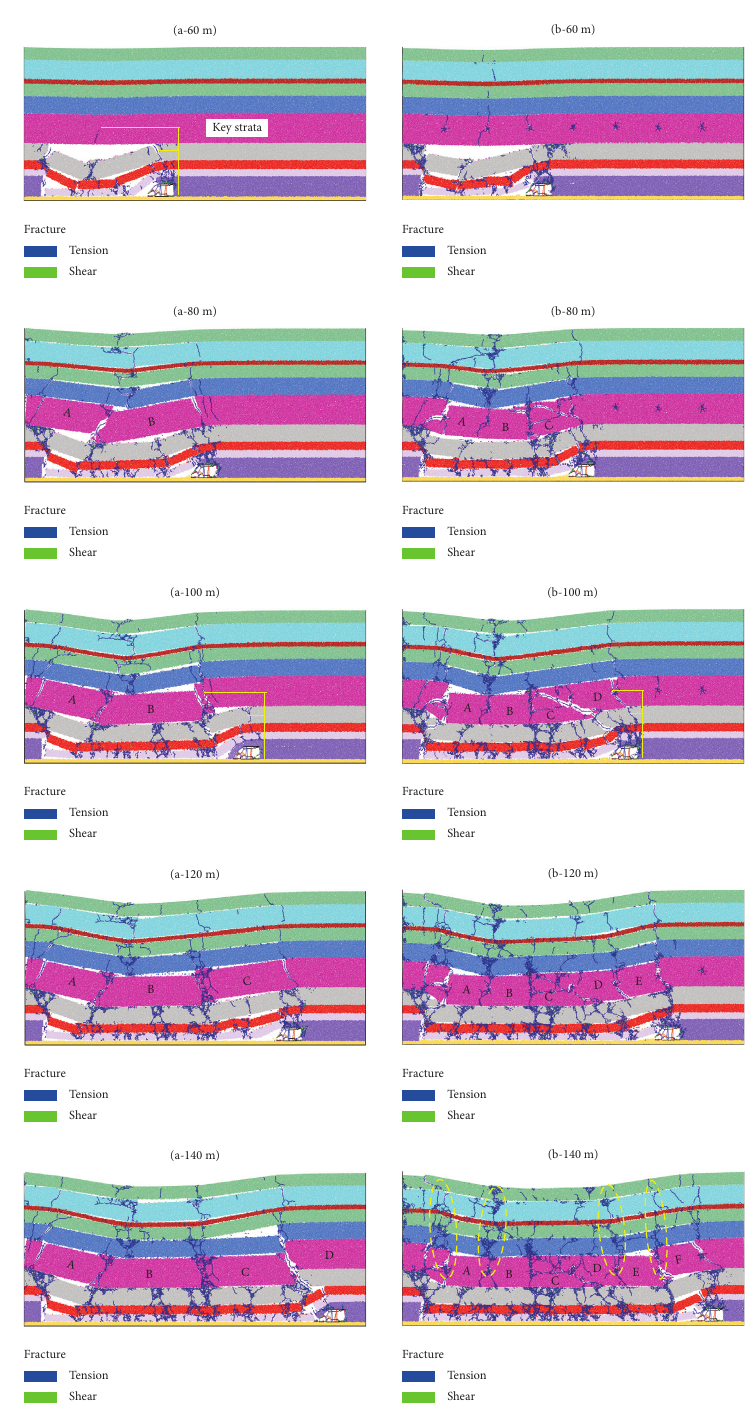
Figure 8: Overburden rock breakage and fracture development during working face